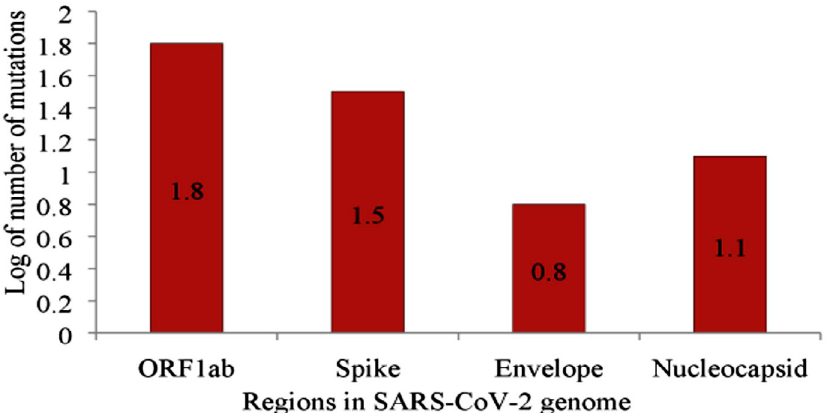
non-synonymous mutations occurring in genome of Fig. 1. Log 10